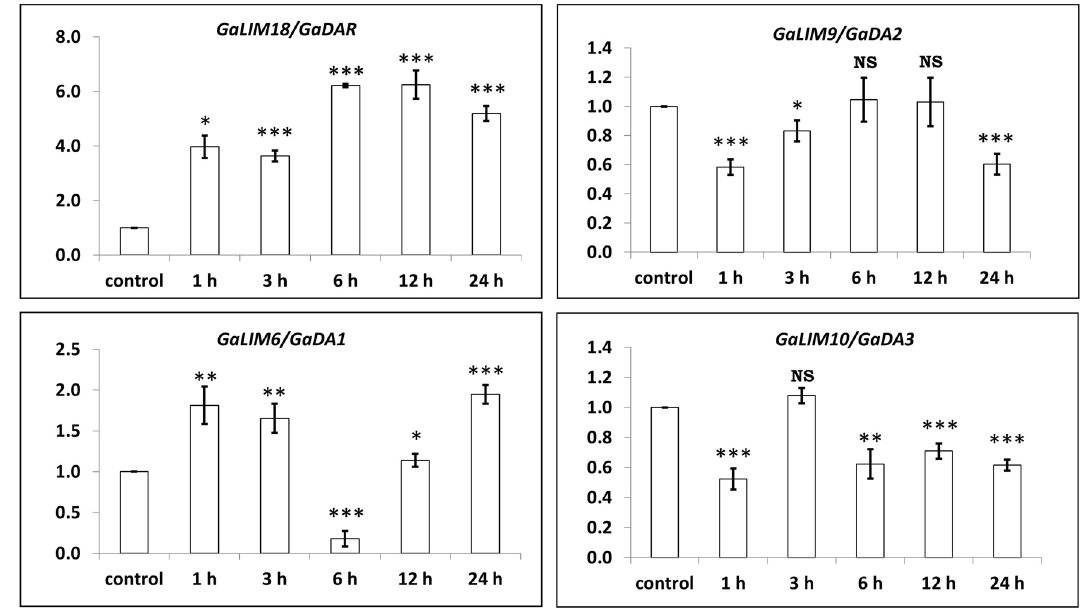
Figure 6. Relative expressions of plant-specific LIM family genes in response to salt treatment.